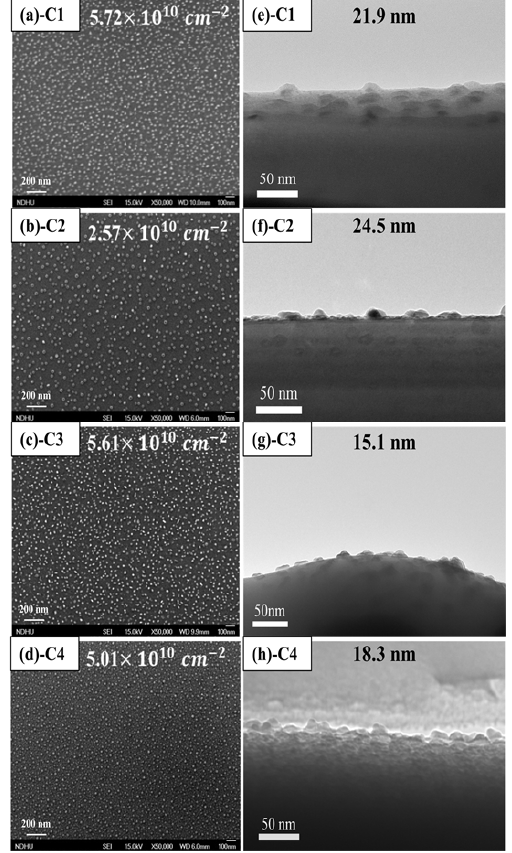
Figure 2. SEM images ( left column ) and cross ‐ section TEM images ( right column ) of GaN nanodots for samples C1, C2, C3 and C4.